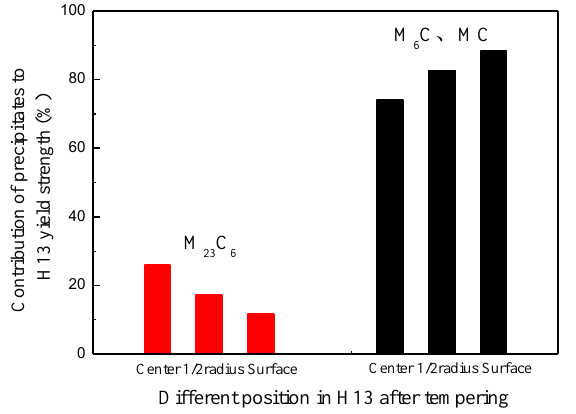
Figure 9. Contribution to yield strength of different types of carbides in different positions in H13 after tempering.